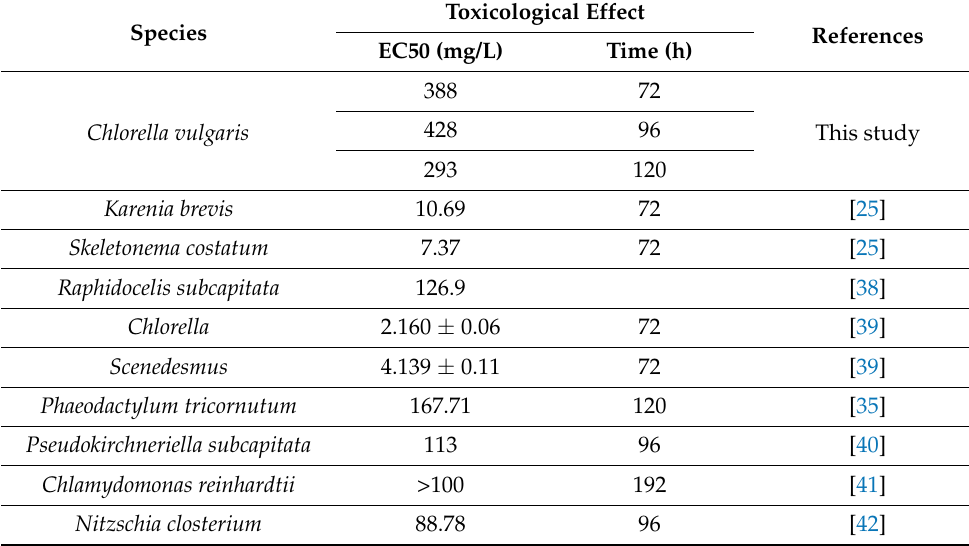
Table 1. Toxicological characterisation of TiO 2 exposure to different types of